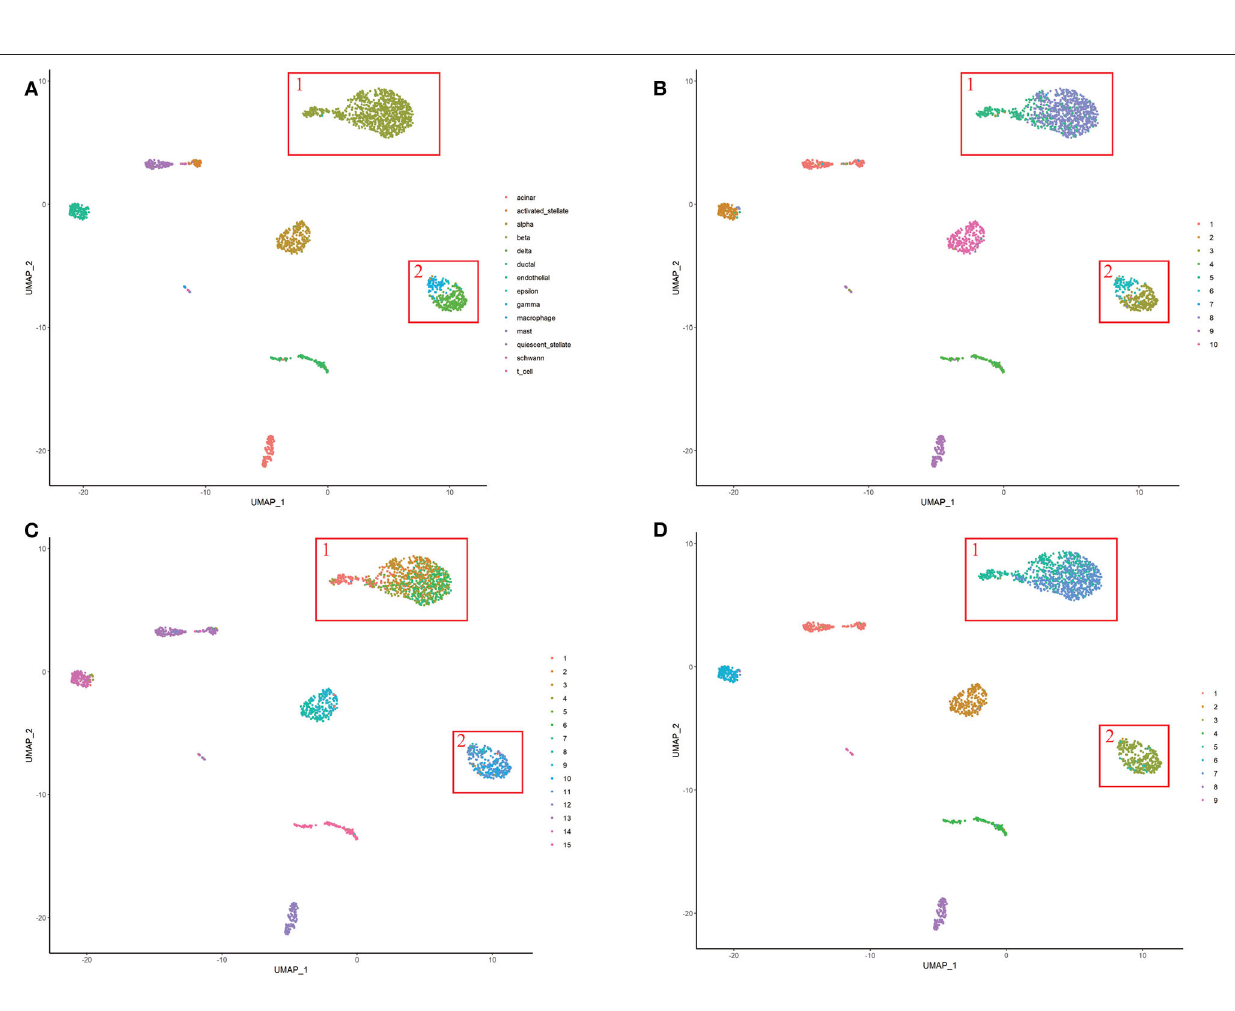
Frontiers in Genetics |